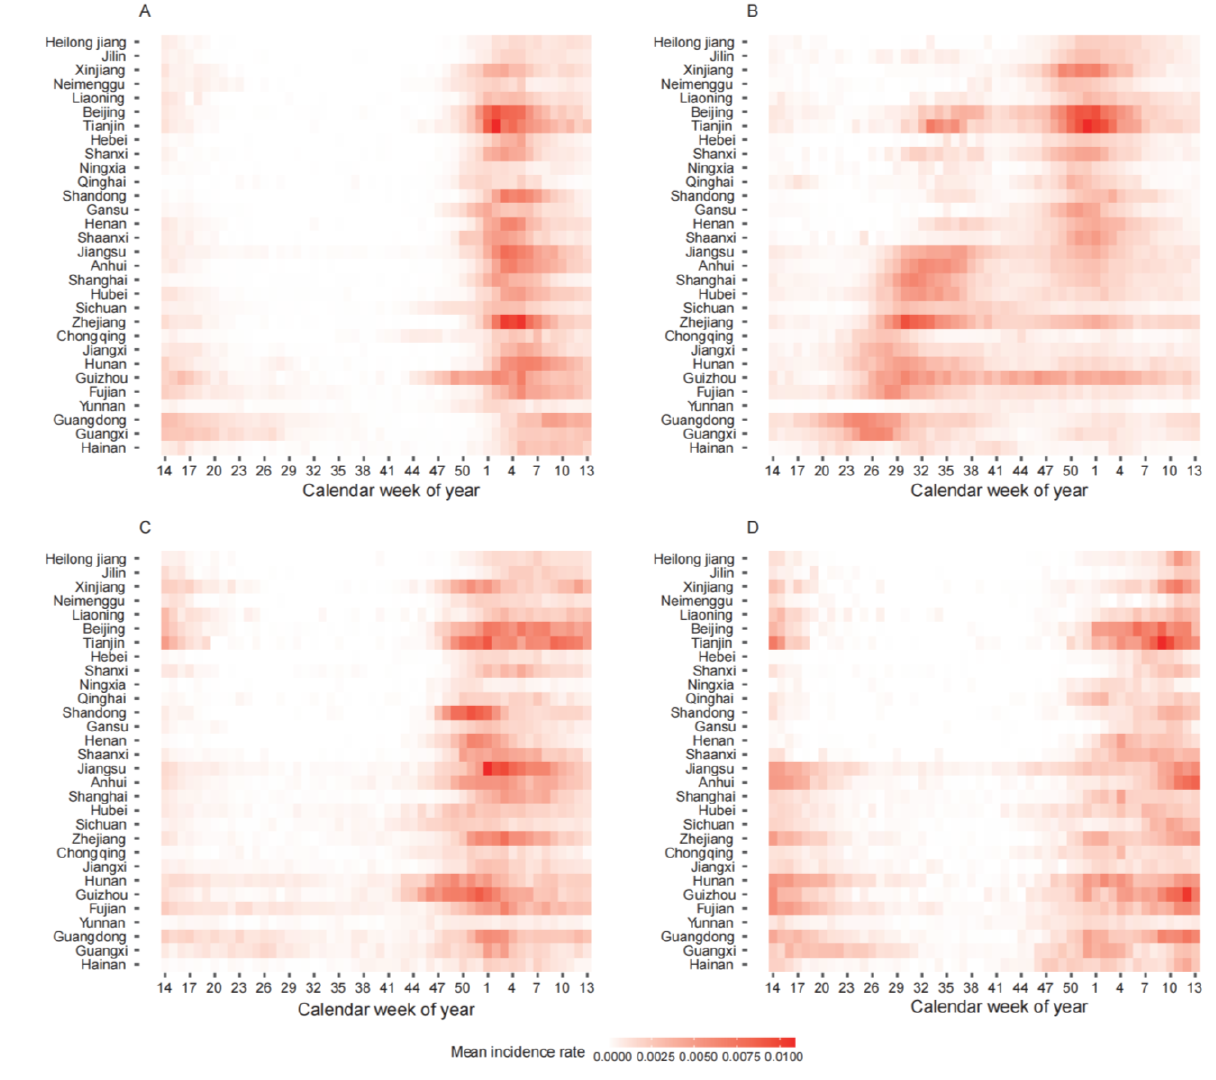
Figure 2. Heatmap for the mean weekly incidence rate of influenza ( A ) A(H1N1)pdm09, ( B ) A(H3N2), ( C ) B/Yamagata, and ( D ) B/Victoria for provinces in China, sorted by increasing latitude from bottom to top.